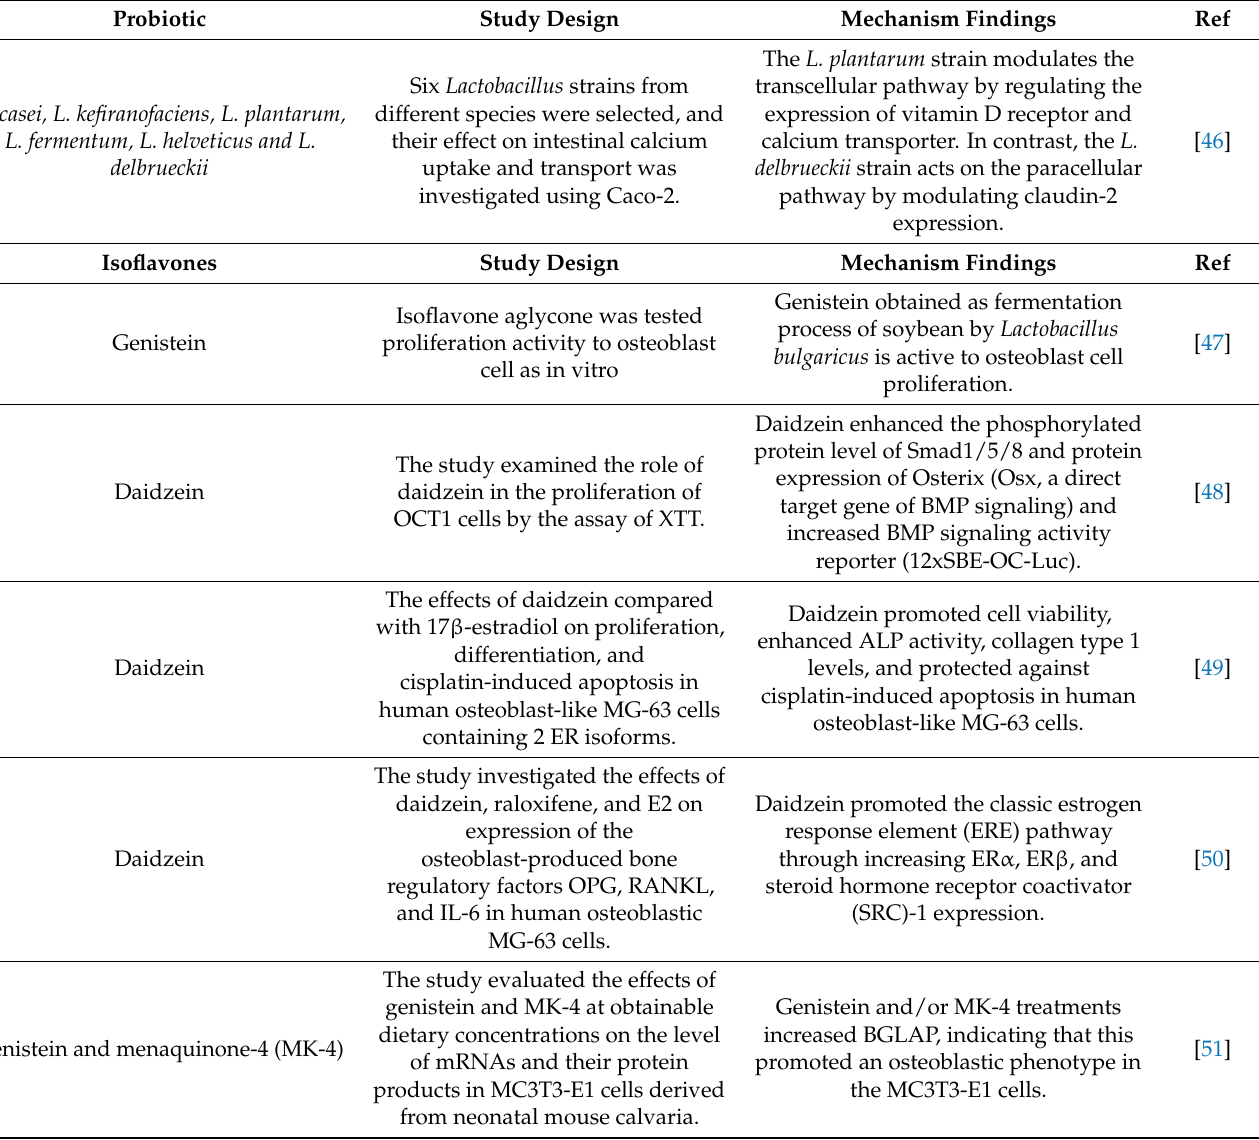
Table 3. Summary of in vitro